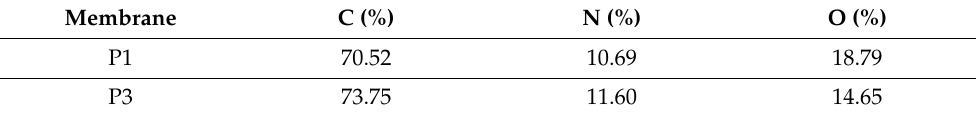
Table 2. Elemental composition by atomic percent of different kinds of PA66 membranes.